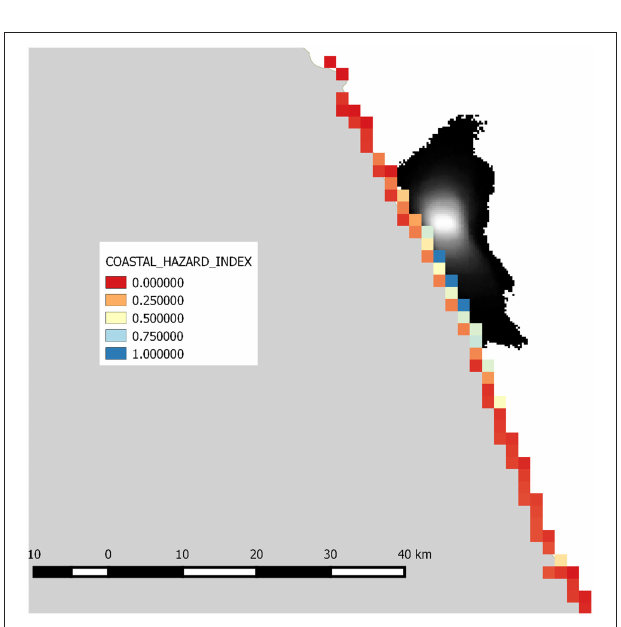
FIGURE 5 | Coastal Hazard Index for the Adriatic platform. In order to compare the extension of the hazard distribution, the shape of the marine OI is also represented in black-to-white. CHI is dimensionless and in the range 0 −